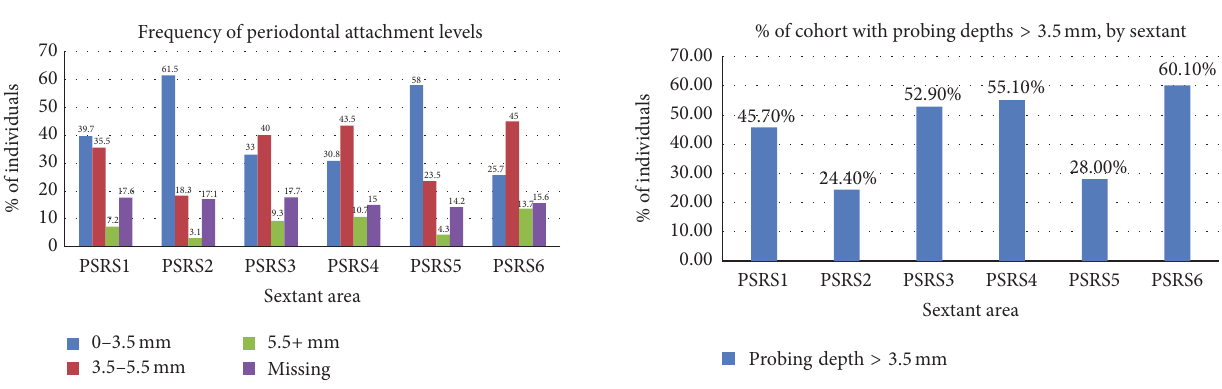
Figure 1: Note. 𝑁 = 1 ,339 adults. Figure 2: Note. Edentulism assumed to be due to periodontal disease, although models with and without this assumption were tested in